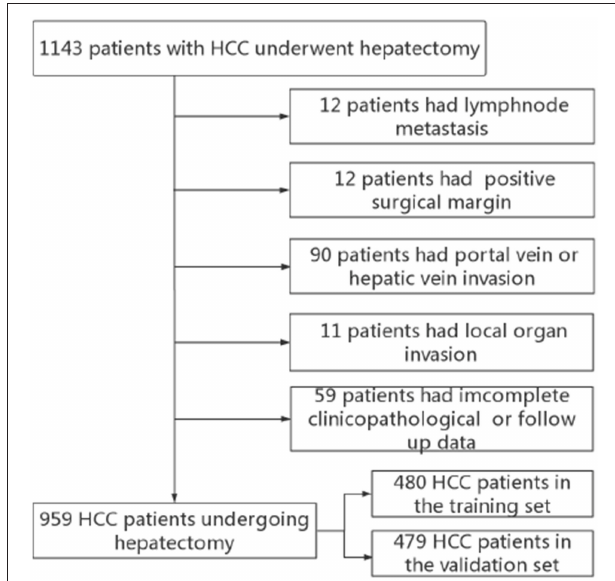
FIGURE 1 | Flow chart for patient enrollment in current study.